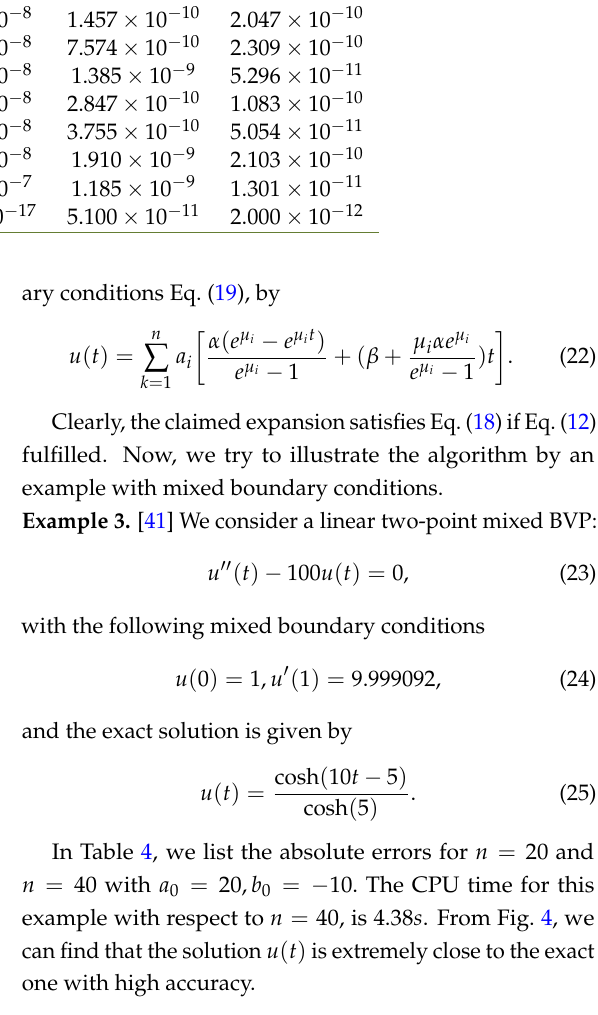
Table 3. The absolute errors | e N ( t ) | for Example 2, for n = 8, n = 12, n = 16 and n =